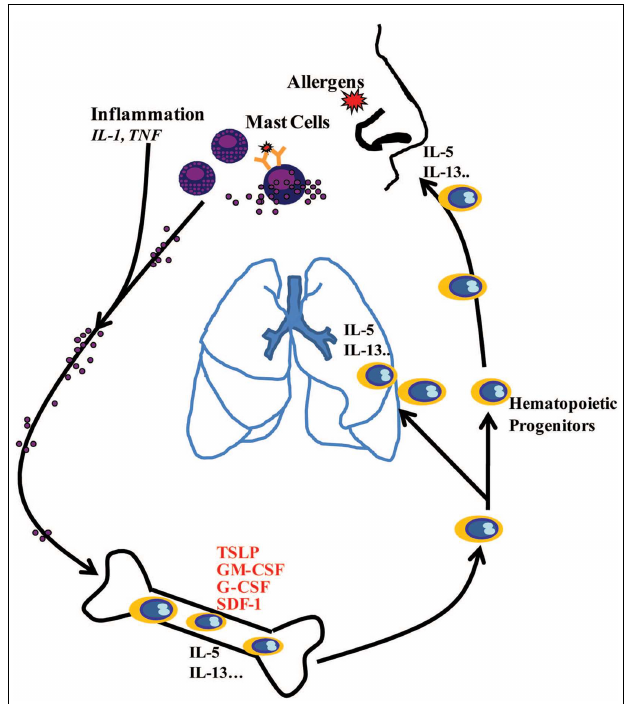
FIGURE 6 | Schematic diagram showing systemic hematopoietic processes involving active communication between mast cells at the site of allergic inflammation and the bone marrow, highlighting how mast cell-released mediators stimulate the bone marrow to produce hematopoietic growth factors, which in turn regulate proliferation and lineage commitment of CD34 + progenitor cells . CD34 + progenitor cells stimulated with MC-primed BM-MSCs may produce IL-5 and IL-13 in the bone marrow and at the sites of allergic inflammation viaTSLP-dependent